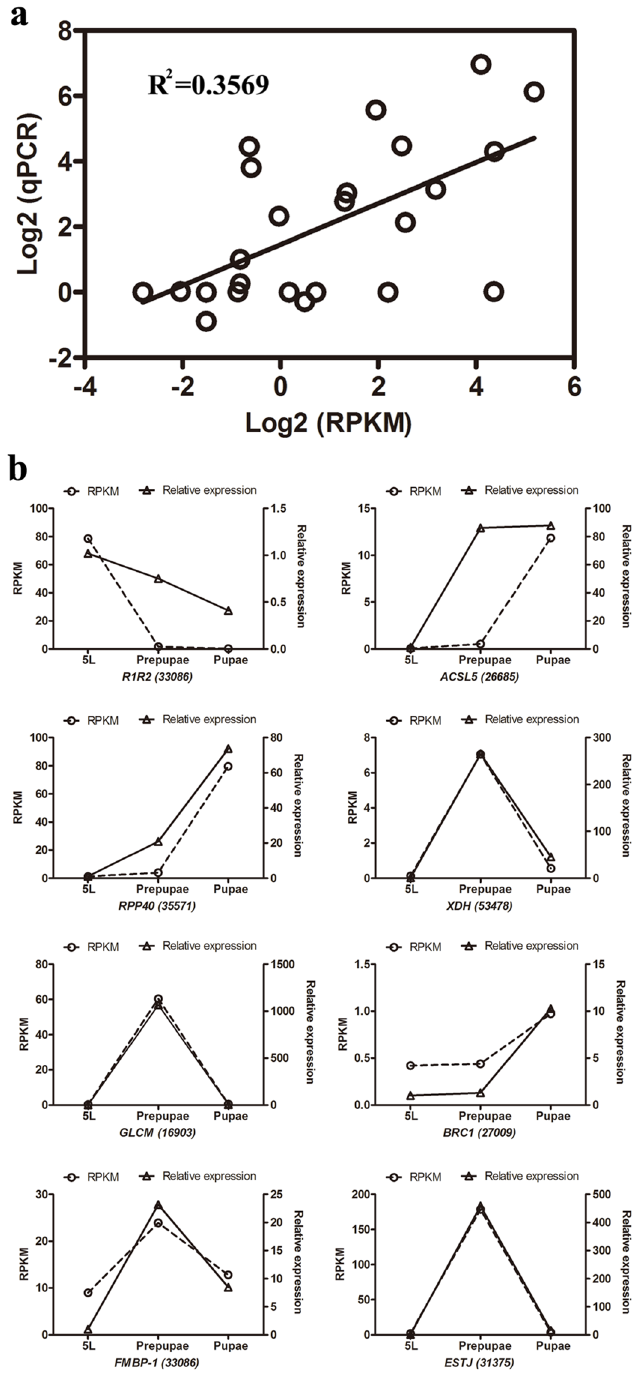
Fig 3. qPCR validation of 8 genes from three CLR developmental stages. (a) Comparison of expression levels measured by RNAseq and qPCR for the selected 8 transcripts in three libraries (5L, Prepupae and Pupae; R 2 = 0.3569). (b) Comparison of expression levels of eight genes recorded by RNAseq and qPCR. Each panel shows gene expression on the left y-axis, determined by RPKM, and relative gene expression determined by qPCR on the right